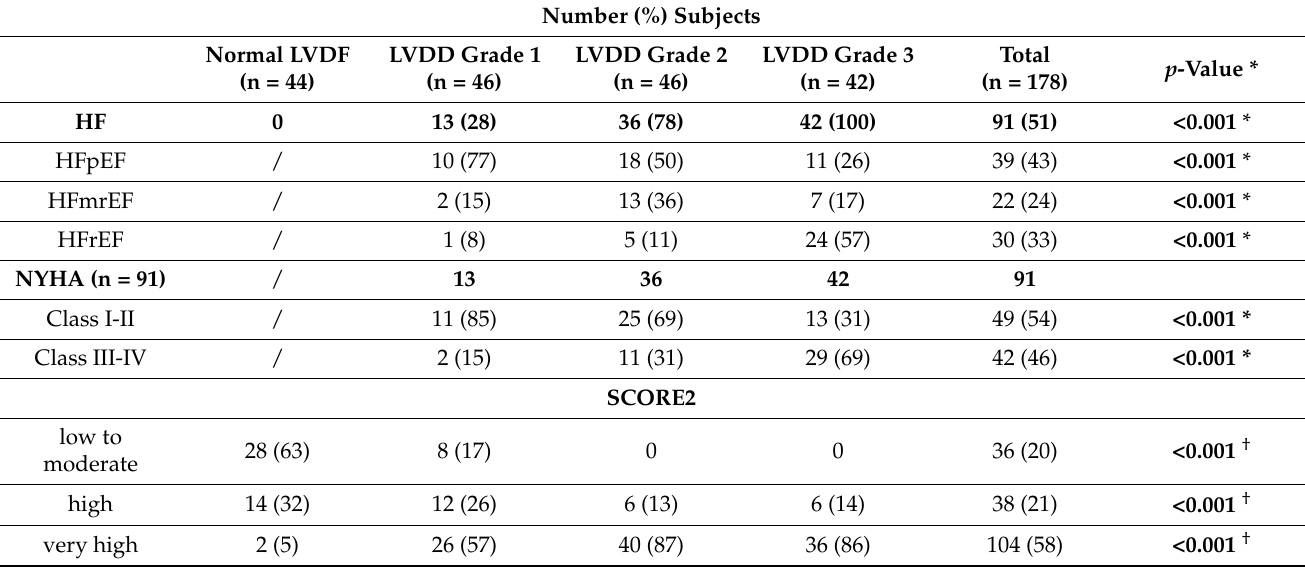
Table 3. Differences between groups in expression of HF, NYHA class, and